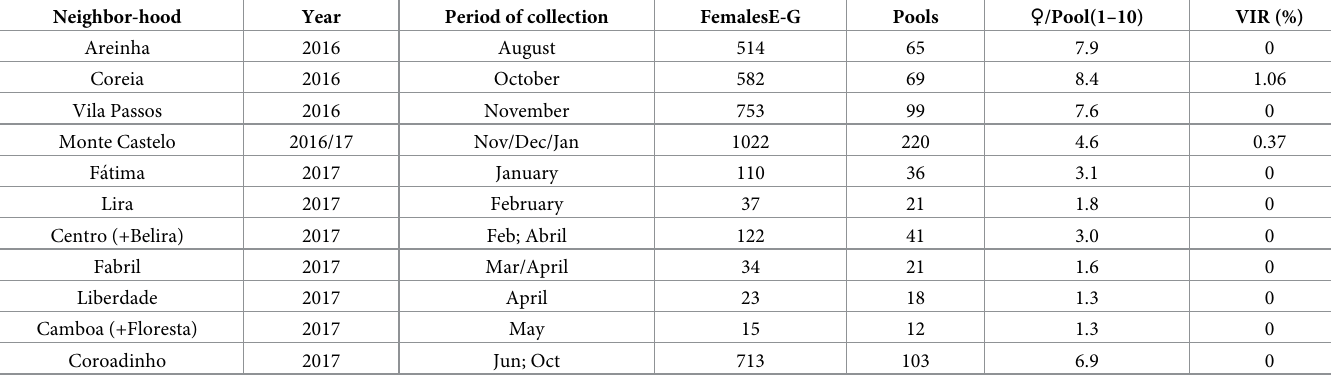
Table 4. Molecular xenomonitoring of the status of LF in S ã o Luı´s, MA, Brazil.